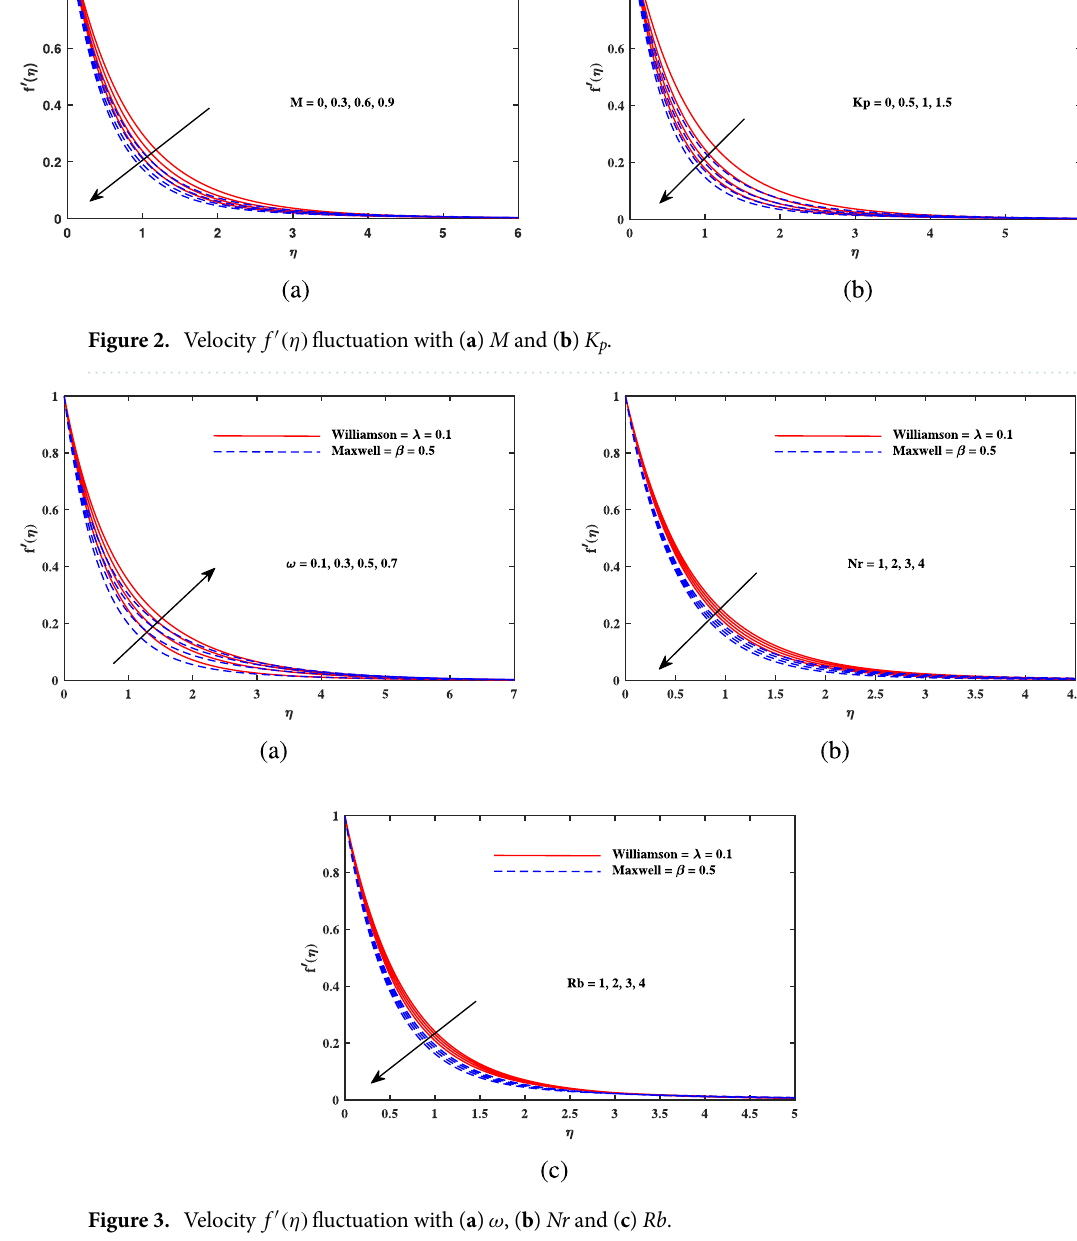
Figure 3. Velocity f ′ (η) fluctuation with ( a ) ω , ( b ) Nr and ( c ) Rb